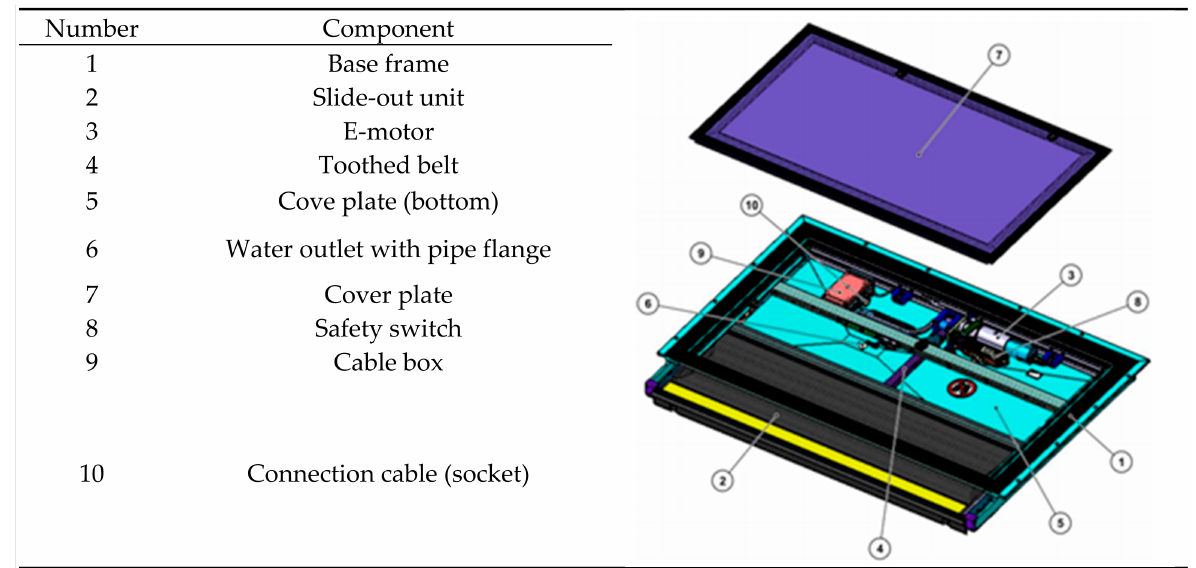
Figure 5. Component description FLIRT retractable step [49].